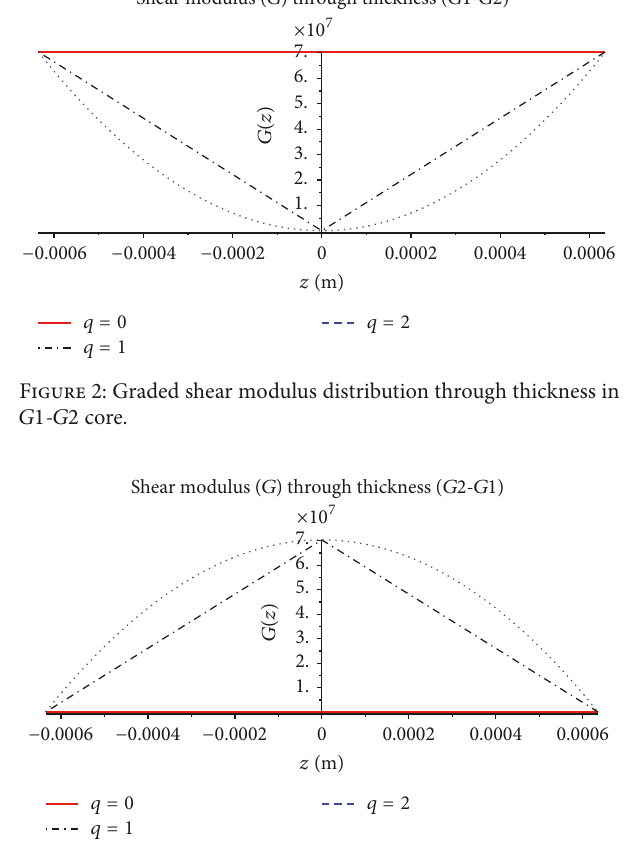
Figure 3: Graded shear modulus distribution through thickness in 𝐺2 - 𝐺1 core.